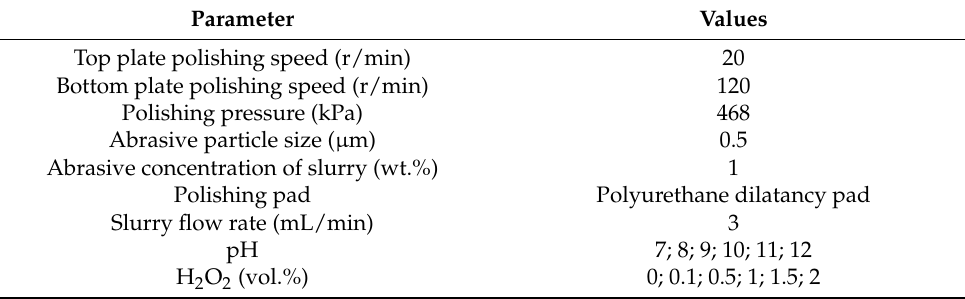
Table 2. Experimental conditions. Parameter Values Top plate polishing speed (r/min) 20 Bottom plate polishing speed (r/min) 120 Polishing pressure (kPa) 468 Abrasive particle size ( µ m) 0.5 Abrasive concentration of slurry (wt.%) 1 Polishing pad Polyurethane dilatancy pad Slurry flow rate (mL/min) 3 pH 7; 8; 9; 10; 11; 12 H 2 O 2